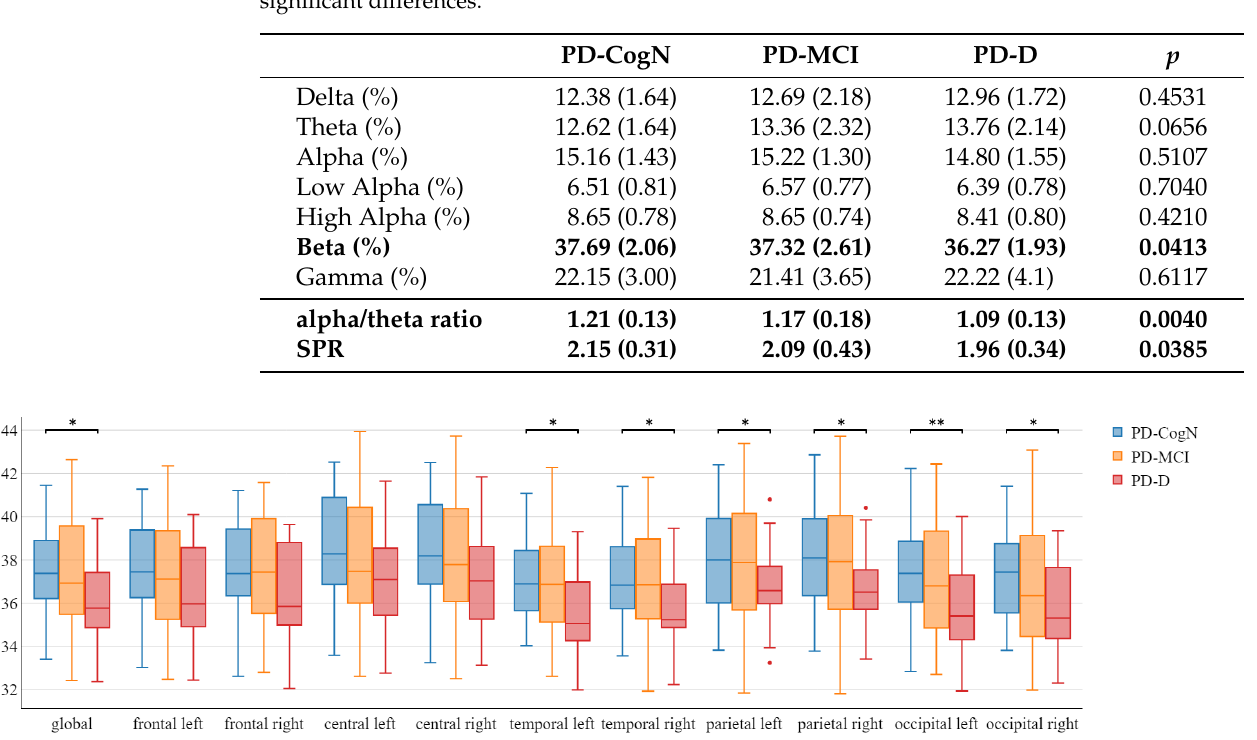
Figure 2. Relative beta power in the different areas between patient’s groups with statistical signifi- cance highlighted (* p < 0.05, ** p <